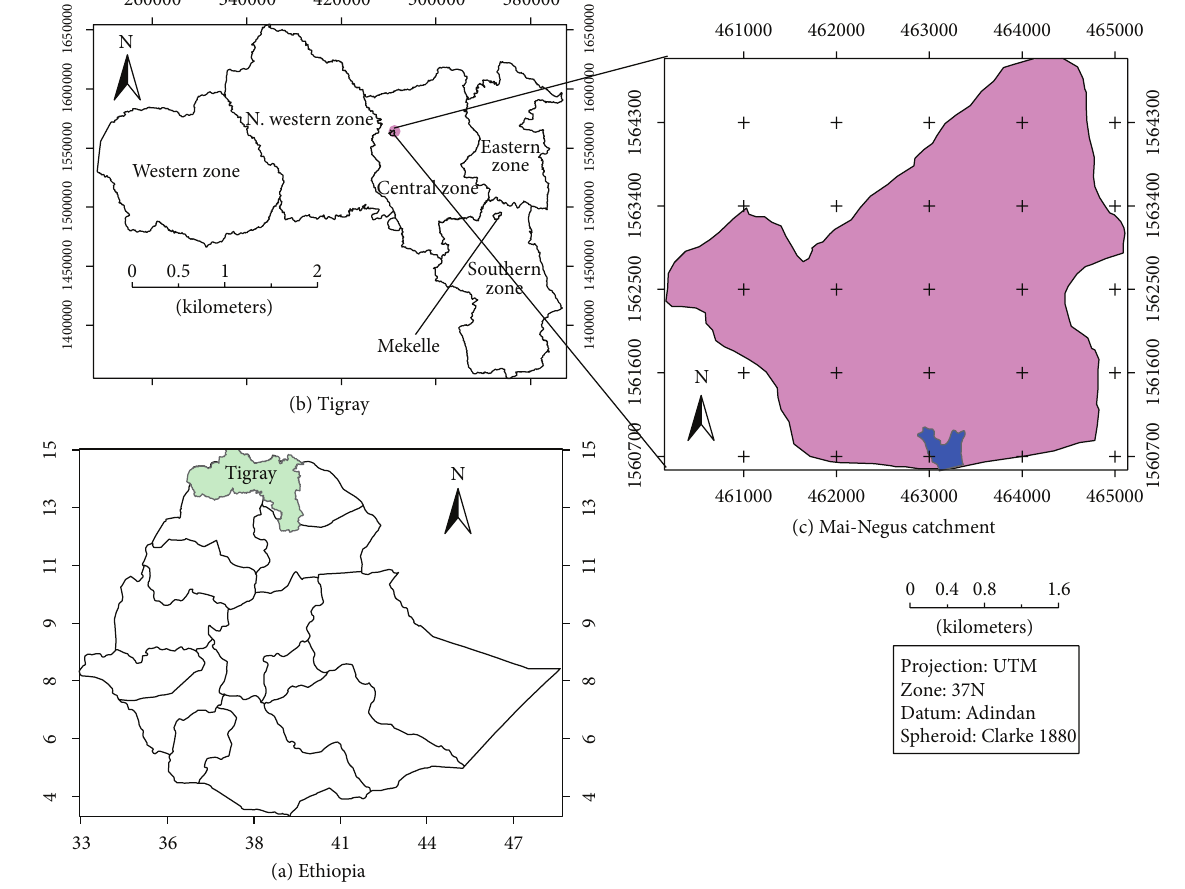
Figure 1: Locations of the study area: Ethiopia (a), Tigray Region (b), and Mai-Negus catchment (study site)